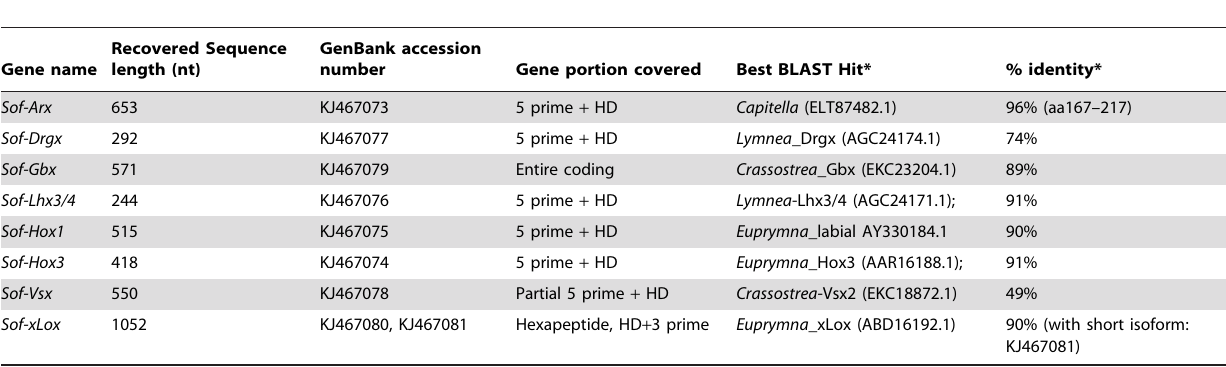
Table 1. Details of recovered HD gene sequences from the European cuttlefish Sepia